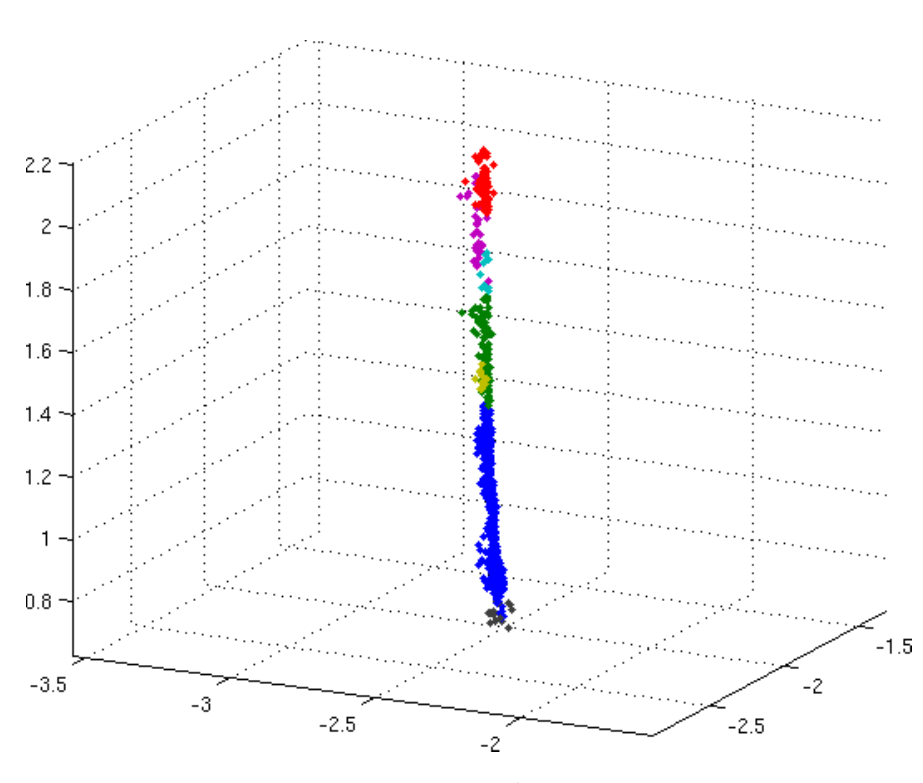
Figure 8. Seven connected stem